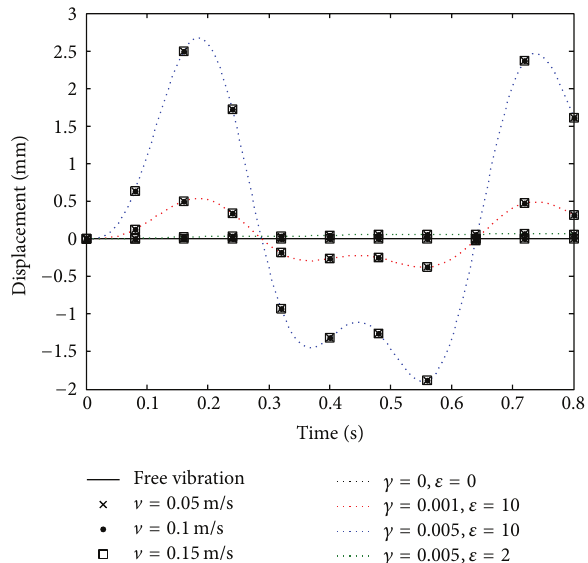
Figure 4:Vibration responsesof theFMMBwithdisturbanceveloc- ities.